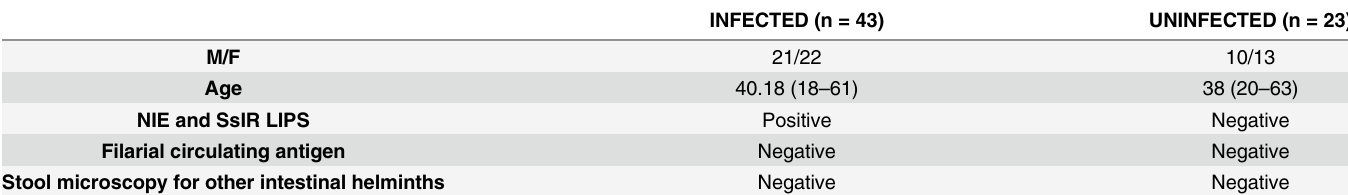
Table 1. Demographics of the study